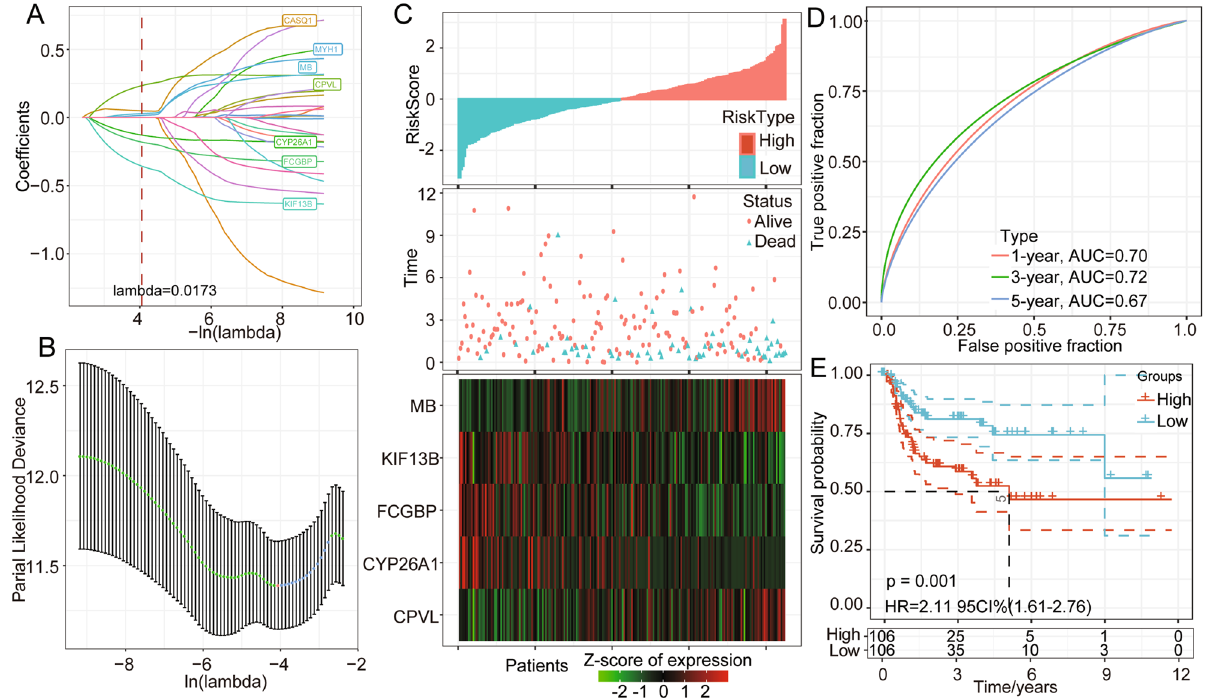
Figure 5. Construction and validation of a m6A phenotype-associated prognostic model. ( A ) The horizontal axis represents the log value of lambda, and the vertical axis represents the coefficient of the independent variable. ( B ) Confidence intervals for each lambda. ( C ) Risk score, survival time, survival status, and expression of 5 genes in the TCGA training group. ( D ) ROC curve and AUC of the 5-gene signature classification. ( E ) KM survival curve distribution between the high- and low-risk scores of the 5-gene signature in the training